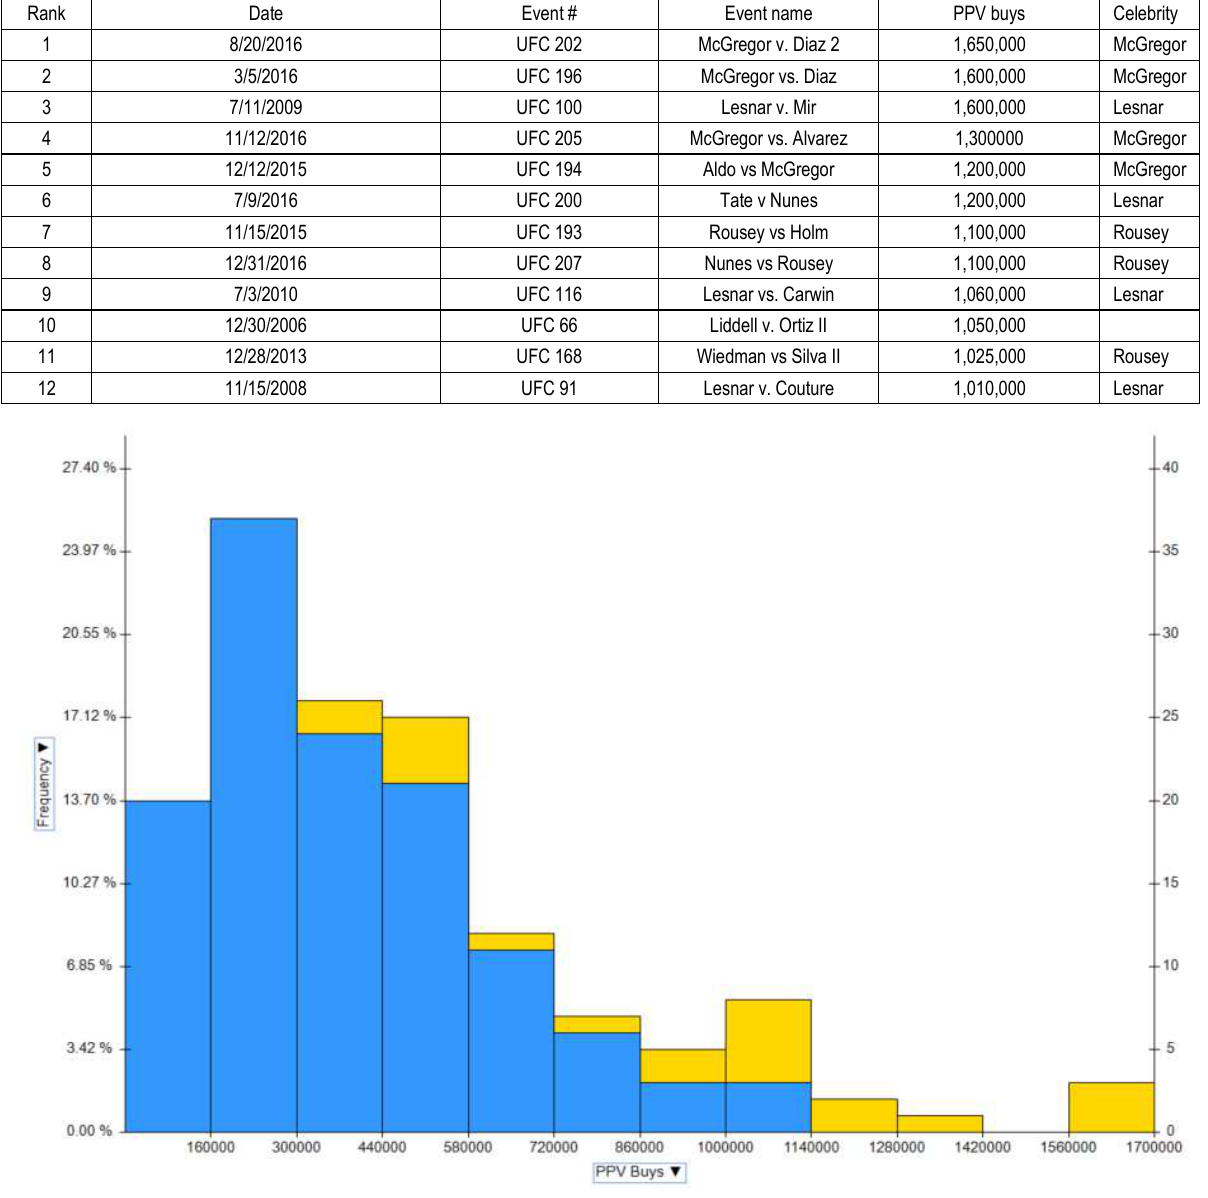
Fig. 5. Histogram coded for top celebrity